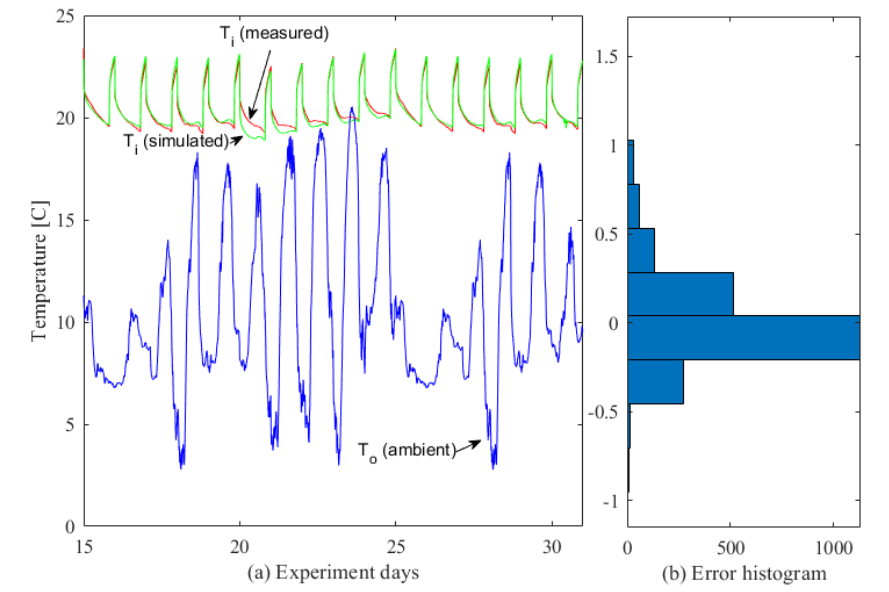
Figure 3. QUB experiments ( a ) simulated temperature (red line) comparison with measured temperature (green line) and outdoor temperature (blue line). ( b ) Simulation error histogram.